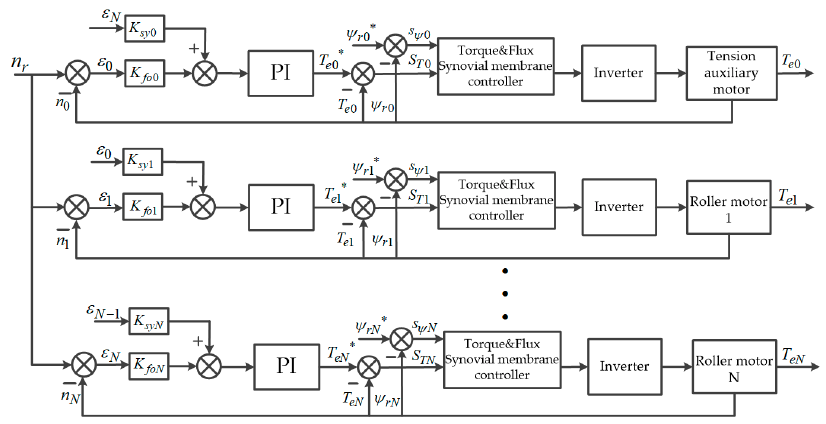
7 of 19 Figure 4. Direct torque controller block diagram based on double sliding mode control. 4.2. Multi-Motor Ring Coupling Control Strategy Conveyors generally transport materials in a single direction. The sudden resistance of a unit during transportation will only cause speed and tension disturbances to the con- veyor belt and the roller motor along the transportation direction. By comprehensively comparing the existing multi-motor control strategies [20,21], a multi-motor ring coupling control strategy is designed. When a single motor cannot overcome the tension fluctuation